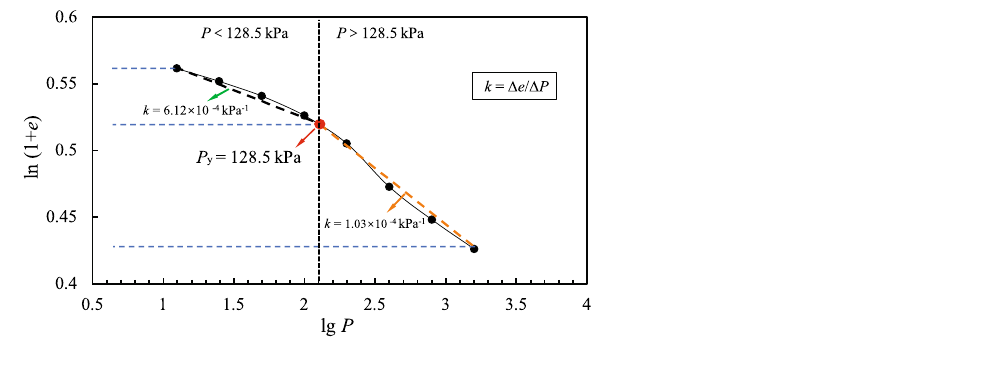
Figure 5. ln(1 + e )–lg P